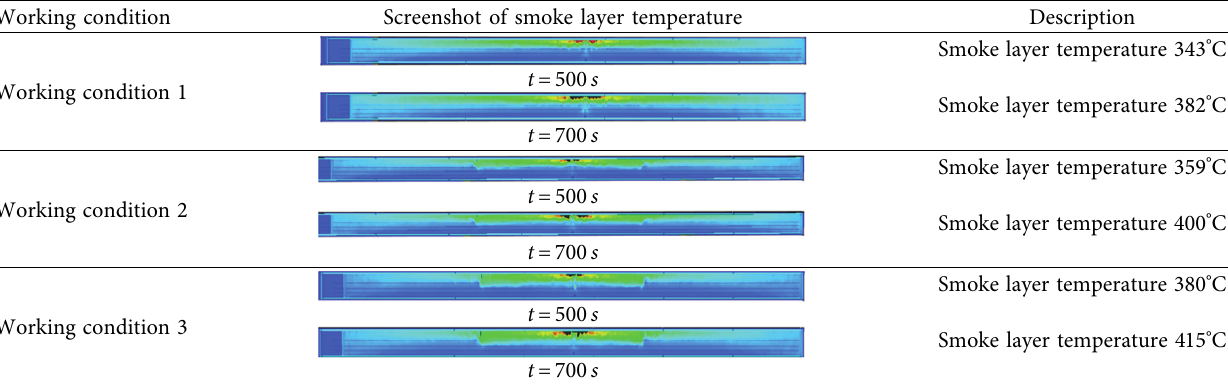
Table 4: Comparison of smoke layer temperatures under working conditions 1, 2, and 3.